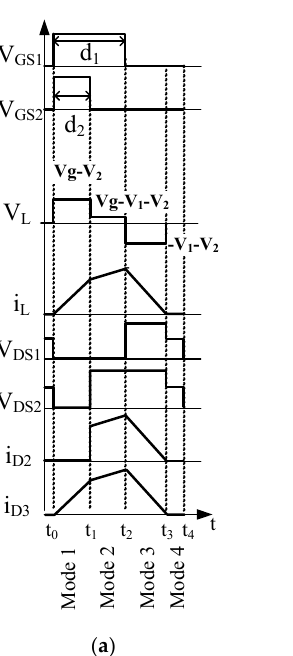
Figure 2. Step-down operation relative waveforms of ( a ) single-battery charging, ( b ) dual-battery charging with the same current.